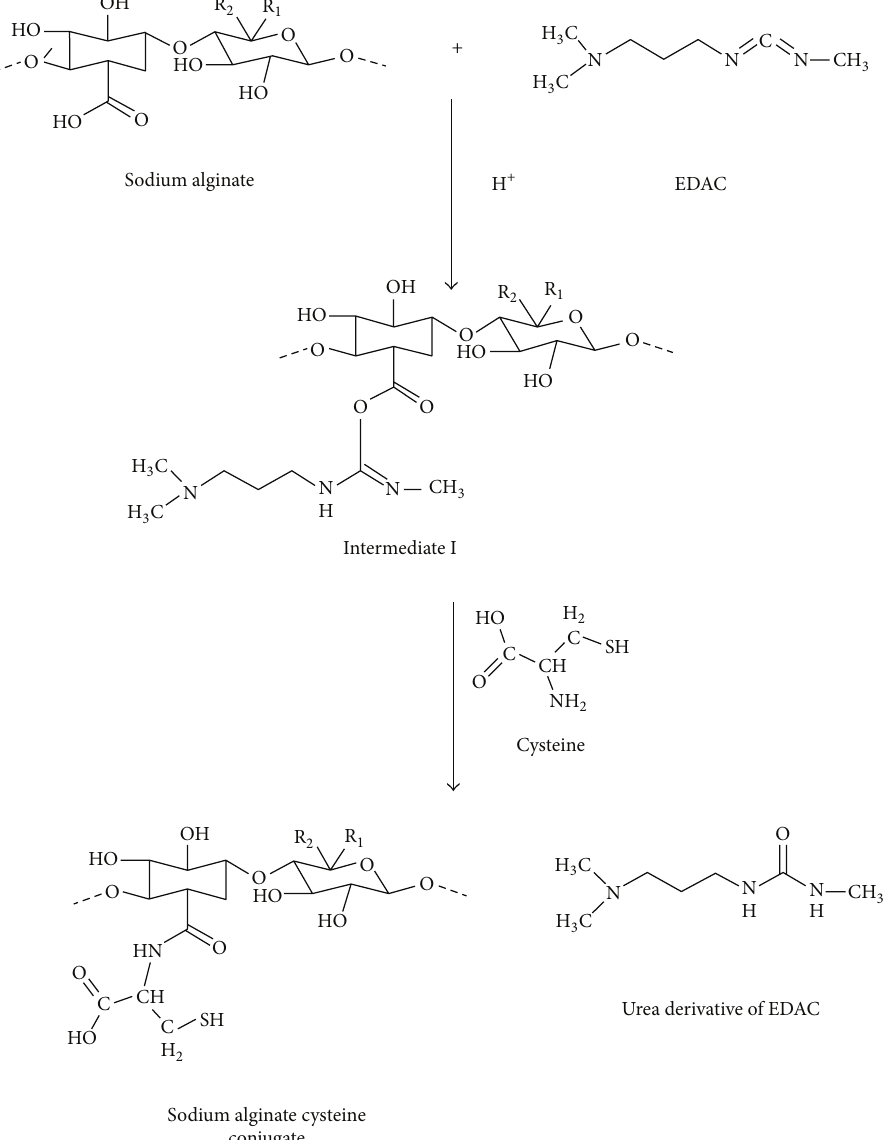
Figure 3: Process for thiolation of sodium